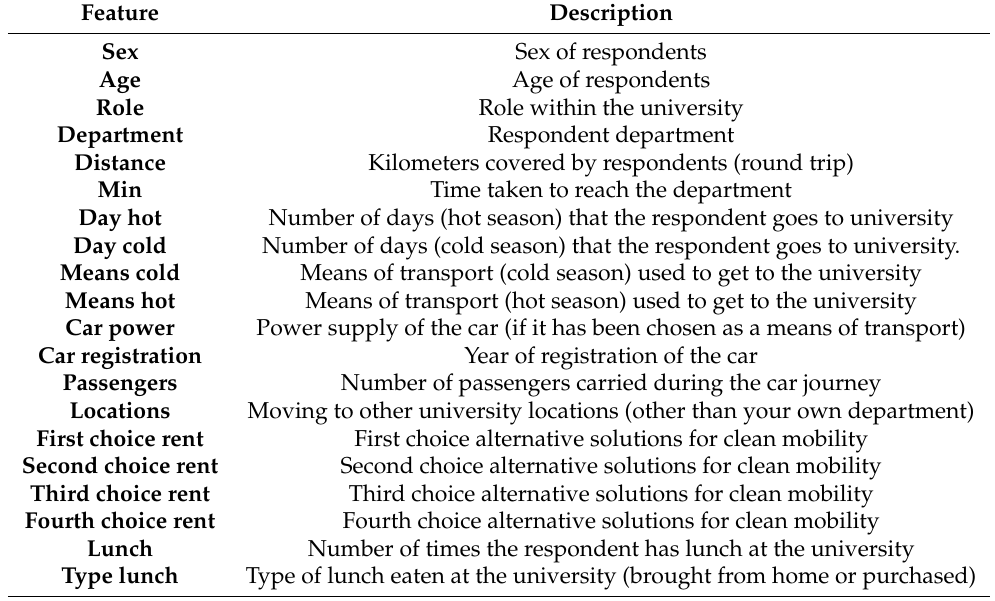
Table 1. Description of the features in the